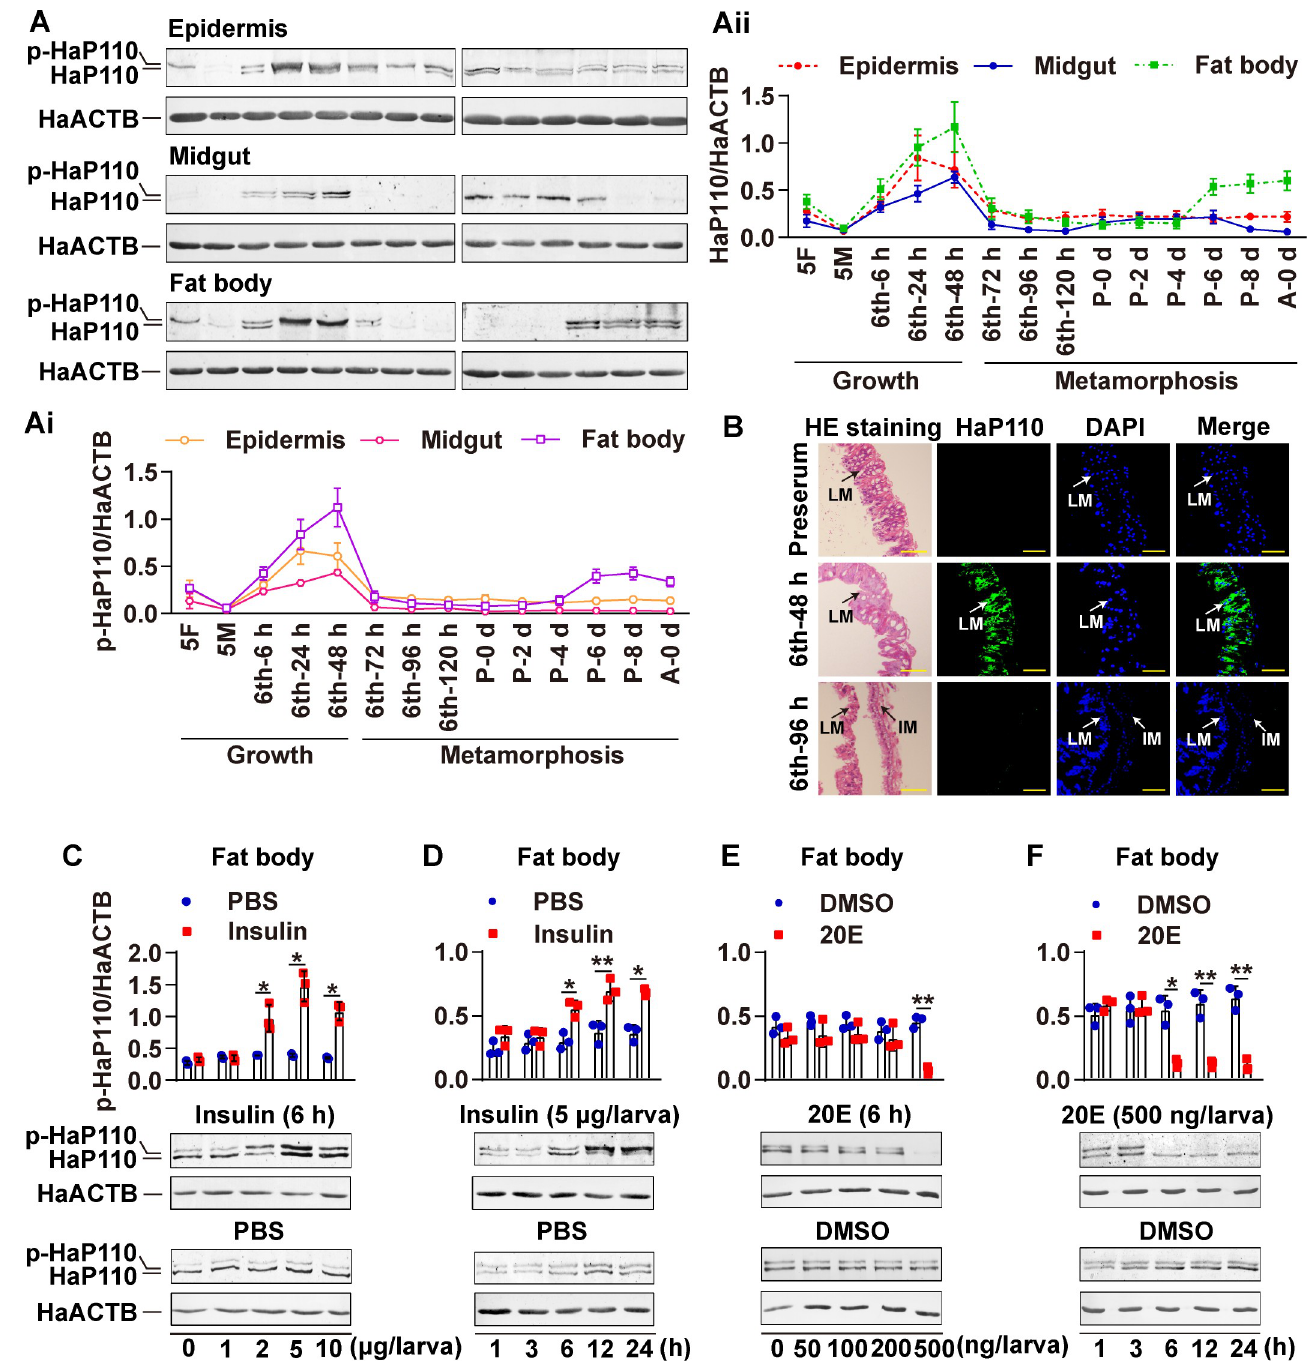
Fig 2. 20E repressed HaP110 phosphorylation and expression. A. Western blotting detection of the expression profiles of HaP110 from the fifth instar to adult in different tissues using anti-HaP110 antibodies. 5F, fifth instar feeding; 5M, fifth instar molting; 6th-6 h-120 h, sixth instar 6 h-120 h; P 0 d-P 8 d, pupa 0 d-8 d; A 0 d, adult 0 d. Ai. The quantitation of phosphorylated HaP110 in A. Aii. The quantitation of HaP110 in A. B. HE staining and immunohistochemistry showed HaP110’s location in the midgut of 6th-48 h and 6th-96 h. Green, HaP110 detected using anti-HaP110 antibodies; blue, nuclei stained using DAPI; merge, overlapped with green and blue; IM, imaginal midgut; LM, larval midgut. Bar, 20 μ m. C and D. Insulin elevated HaP110 phosphorylation and expression in a dose and time dependent manner, respectively. E and F. 20E increased HaP110 dephosphorylation but decreased HaP110 expression in a dose and time dependent manner. All experiments were repeated at least three times. Every column contained three blue dots or red squares represents the quantitation of independently repeated three experiments. � P < 0.05 and �� P < 0.01 using two-tailed Student’s t -test. The bars indicate mean ± SD.